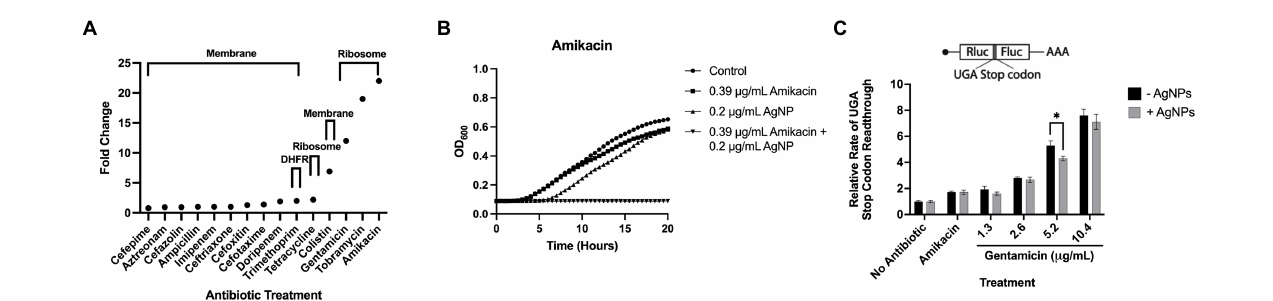
FIGURE 8 Antimicrobial efficacy of AgNPs in combination with antibiotics. (A) A graph representing the enhancement of E. coli DH5 α inhibition (Fold Change) upon treatment with 0.2 μ g/mL AgNPs and various combinations of antibiotics that target the bacterial membrane, DHFR, and the ribosome. (B) E. coli DH5 α growth curves assessing the antimicrobial effect of AgNPs alone or in combination with amikacin. Data represent the average of three independent runs with three replicates each. (C) Bar graphs representing relative rates of readthrough the UGA stop codon in the absence ( − AgNPs) and presence (+ AgNPs) of nanoparticles in combination with aminoglycoside antibiotics, amikacin (10.4 μ g/mL) and gentamicin (1.3–10.4 μ g/mL). Each bar is an average of a minimum of three biological replicates. Error bars represent